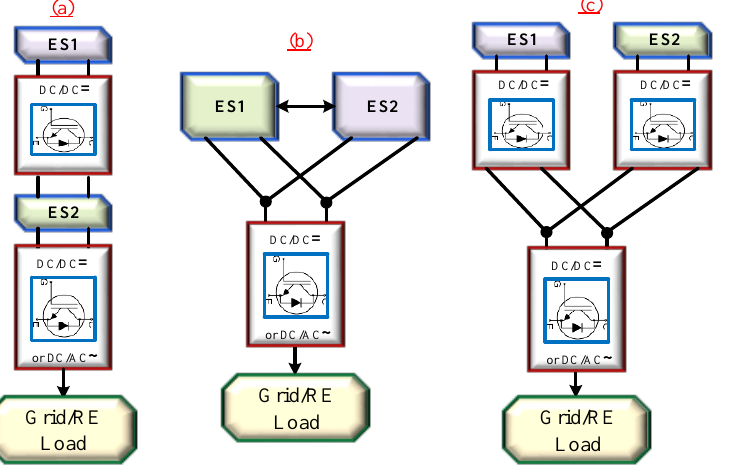
Figure 10. Structure of ES hybridization: ( a ) cascade, ( b ) passive (direct) parallel, and ( c ) active parallel.